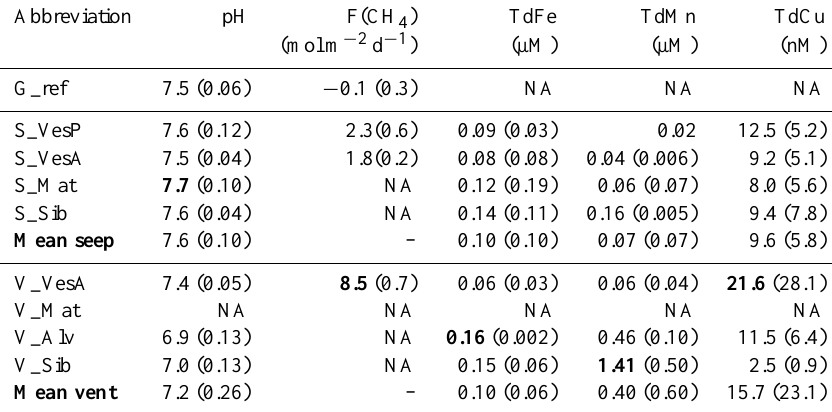
Table 3. Supplementary physico-chemical factors measured for some assemblages: pH, methane flux (F(CH 4 )), total dissolved iron (TdFe), total dissolved manganese (TdMn) and total dissolved copper (TdCu). Due to sampling limitations, these factors were not available for all assemblages. Standard deviations are given in parentheses and the highest values per factor are shown in